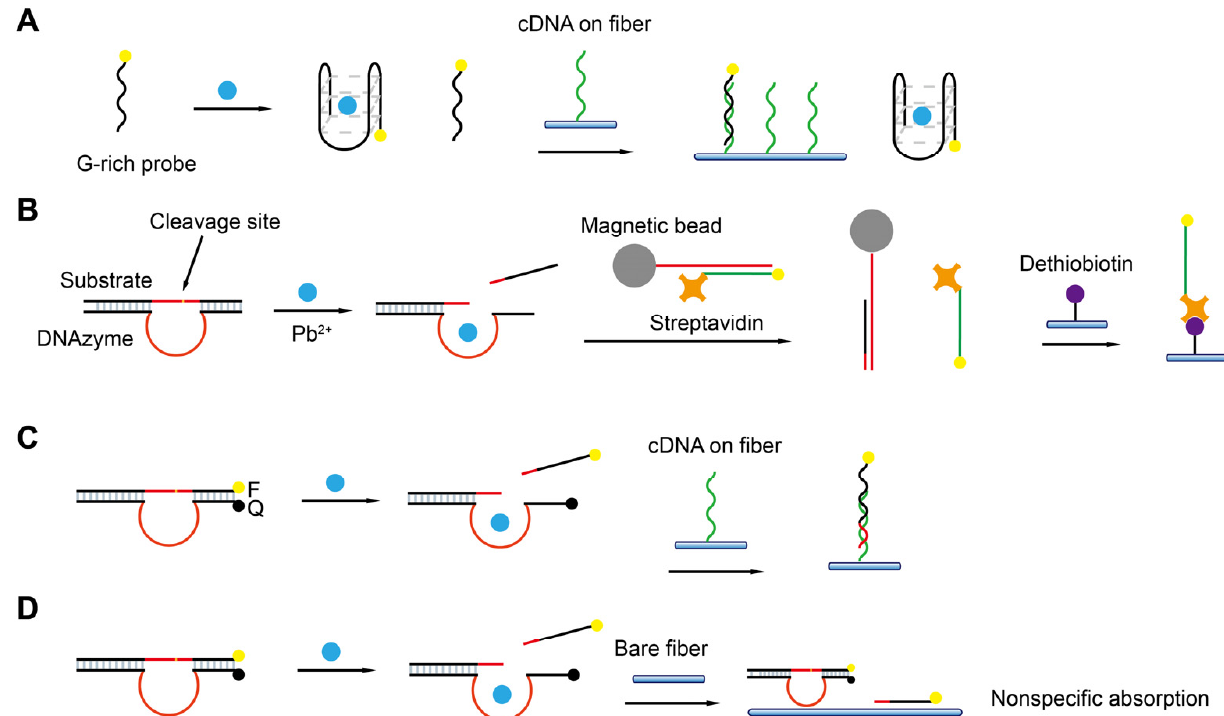
Figure 13. Schematic diagrams of FOEW sensors for Pb 2+ detection using ( A ) G-rich probe [99] or DNAzymes via ( B ) o ffl ine magnetic-separation-based strategy [65] and ( C , D ) separation-free means enabled by cDNA functionalized fi ber [79] or bare fi ber [100] .